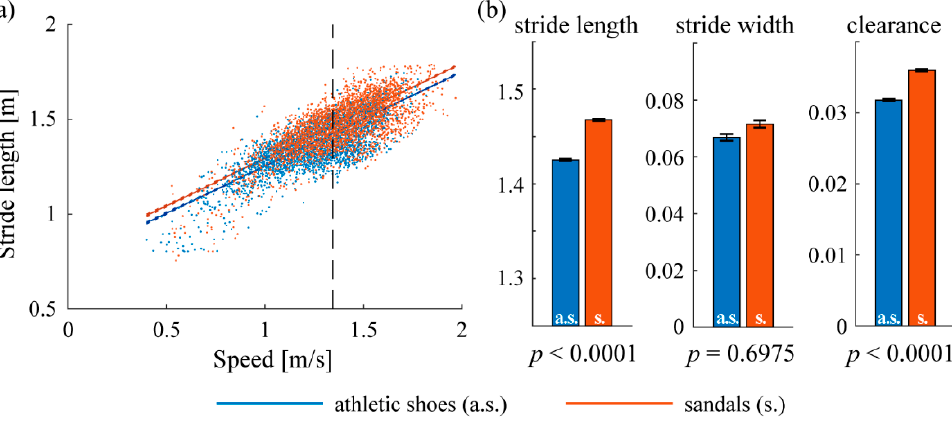
Figure 8 . Spatiotemporal gait parameters using all straight-line walking bouts longer than 15 m. All conventions are similar to Figure 7. ( a ) Linear regression of stride length on walking speed showing the mean speed (1.34 m/s) where population marginal means of the two conditions are compared. ( b ) Population marginal means of stride length, stride width, and clearance; error bars indicate 95% confidence intervals.